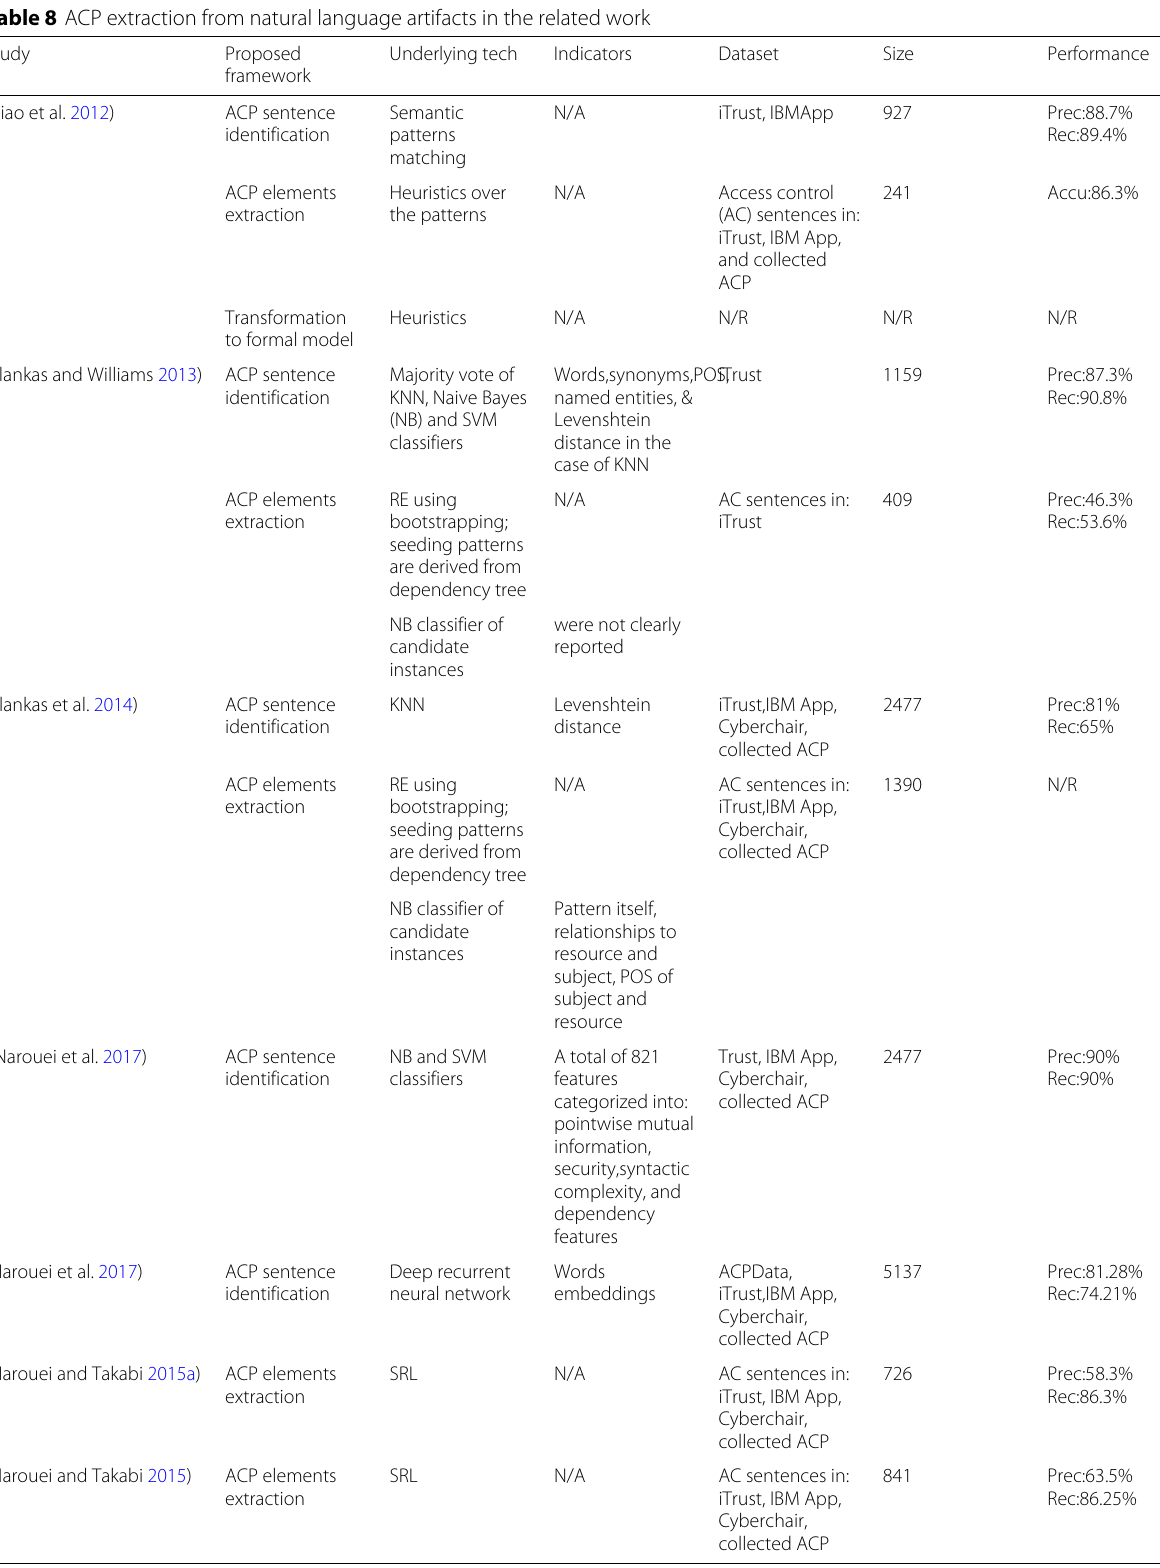
Table 8 ACP extraction from natural language artifacts in the related